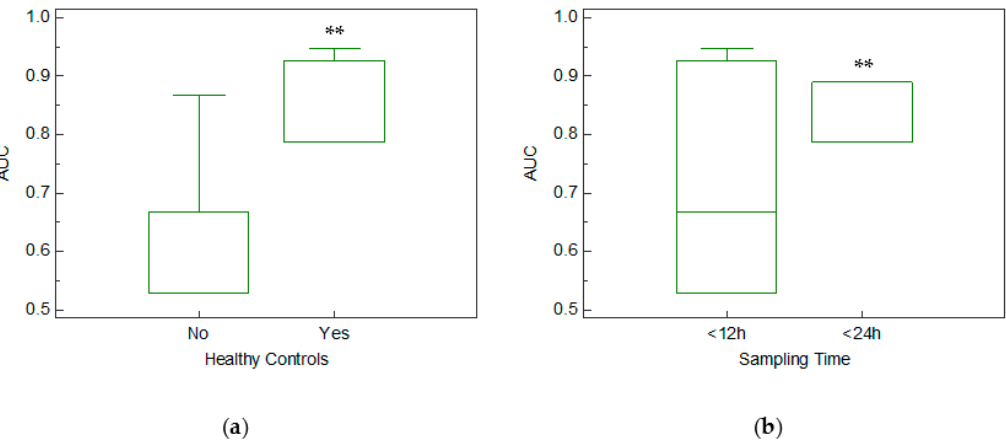
Figure 4. ( a ) Boxplot comparing AUC values based on control group characteristics (AUC was 0.89 ± 0.06 and 0.68 ± 0.14 when healthy or unhealthy controls were used, respectively), * p < 0.001. ( b ) Boxplot comparing AUC values based on sampling time (AUC was 0.82 ± 0.05 and 0.71 ± 0.01 for studies in which samples were acquired within 24 and 12 h, respectively). ** p < 0.001.